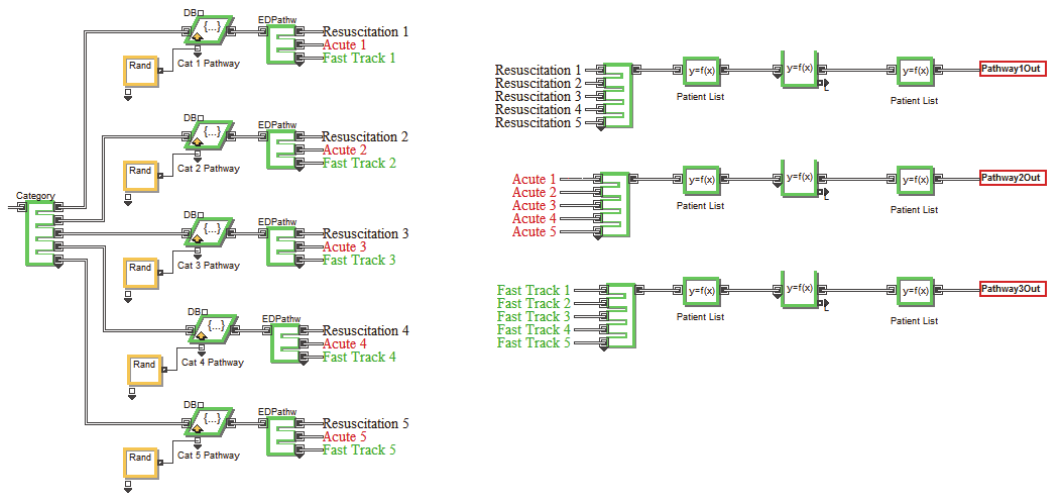
Fig. 7. ExtendSim model of the ED pathway